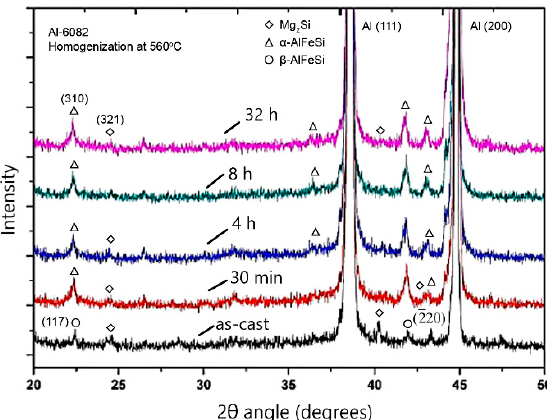
Figure 10. X-ray diffraction spectra after homogenization at 560 °C for 0.5, 4, 8, and 32 h, indicating dissolution of Mg 2 Si and transformation of β -AlFeSi to α -AlFeSi. Alphabetical Indexes for experimental patterns, International Center for Diffraction Data (ICCD). α -AlFeSi: PDF #01-071-4015; β -AlFeSi; PDF #41-0894; Mg2Si: PDF#35-0773.